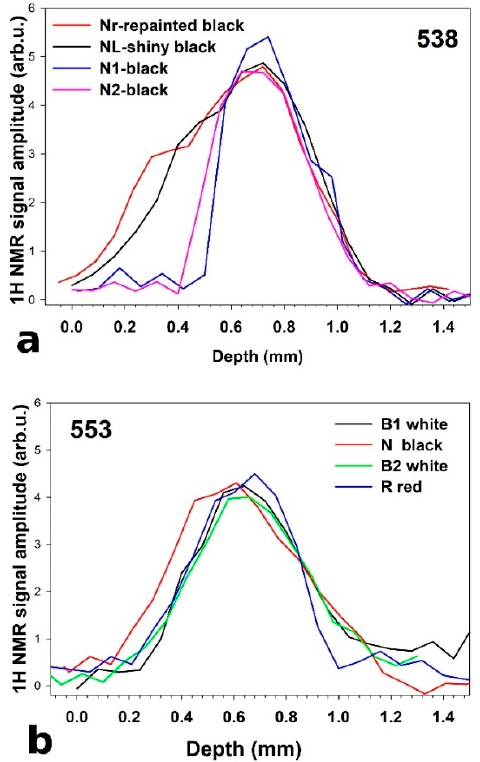
Figure 3. 1 H NMR depth profiles of painted areas in: ( a ) “Surface 538”; ( b ) “Surface 553”.